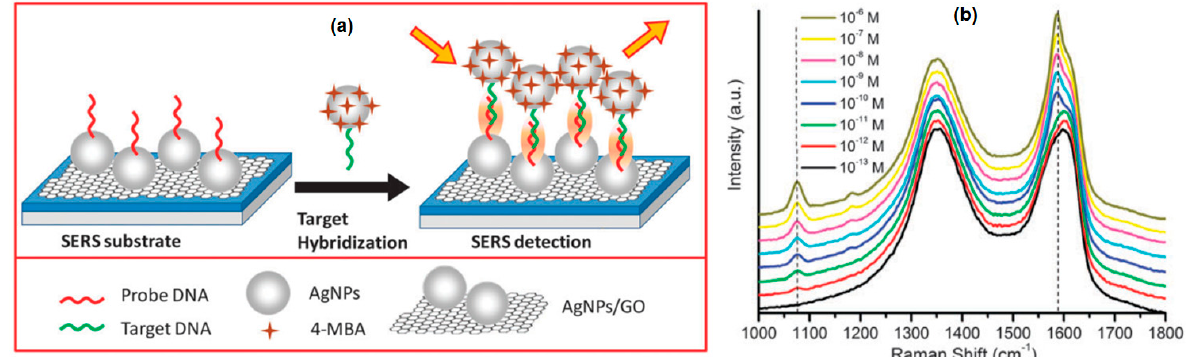
Figure 29. ( a ) Illustration of detection of DNA targets with Ag NPs-Ag NPs-GO. ( b ) The SERS spectrum was obtained at different complement DNA target concentrations (Reproduced from Reference [113] with permission from the PCCP Owner Societies).